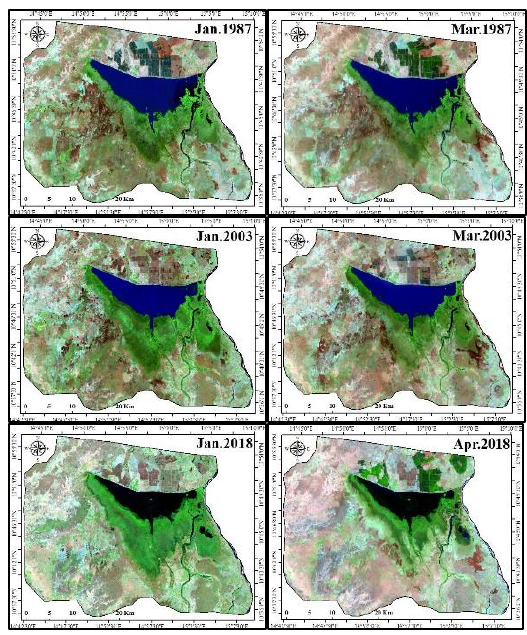
Figure 2. Landsat images in SWIR2-NIR-Red colour Pre-processing help to minimize the effects of sensor, solar, atmospheric and topographic distortions. The images used are Level-1 products, which are delivered as digital numbers, DNs. Bands blue, green, red, near infrared, and both shortwave infrared were stacked.